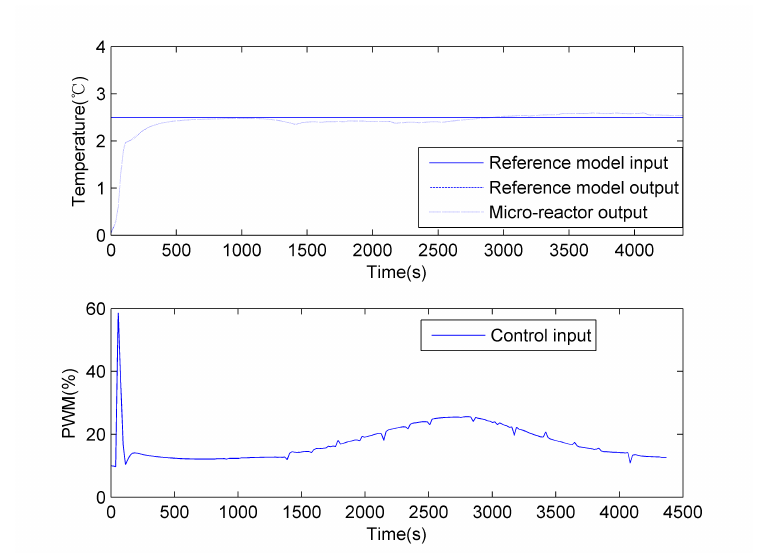
Figure 10. Simulation results of the proposed method for time-varying NCSs.